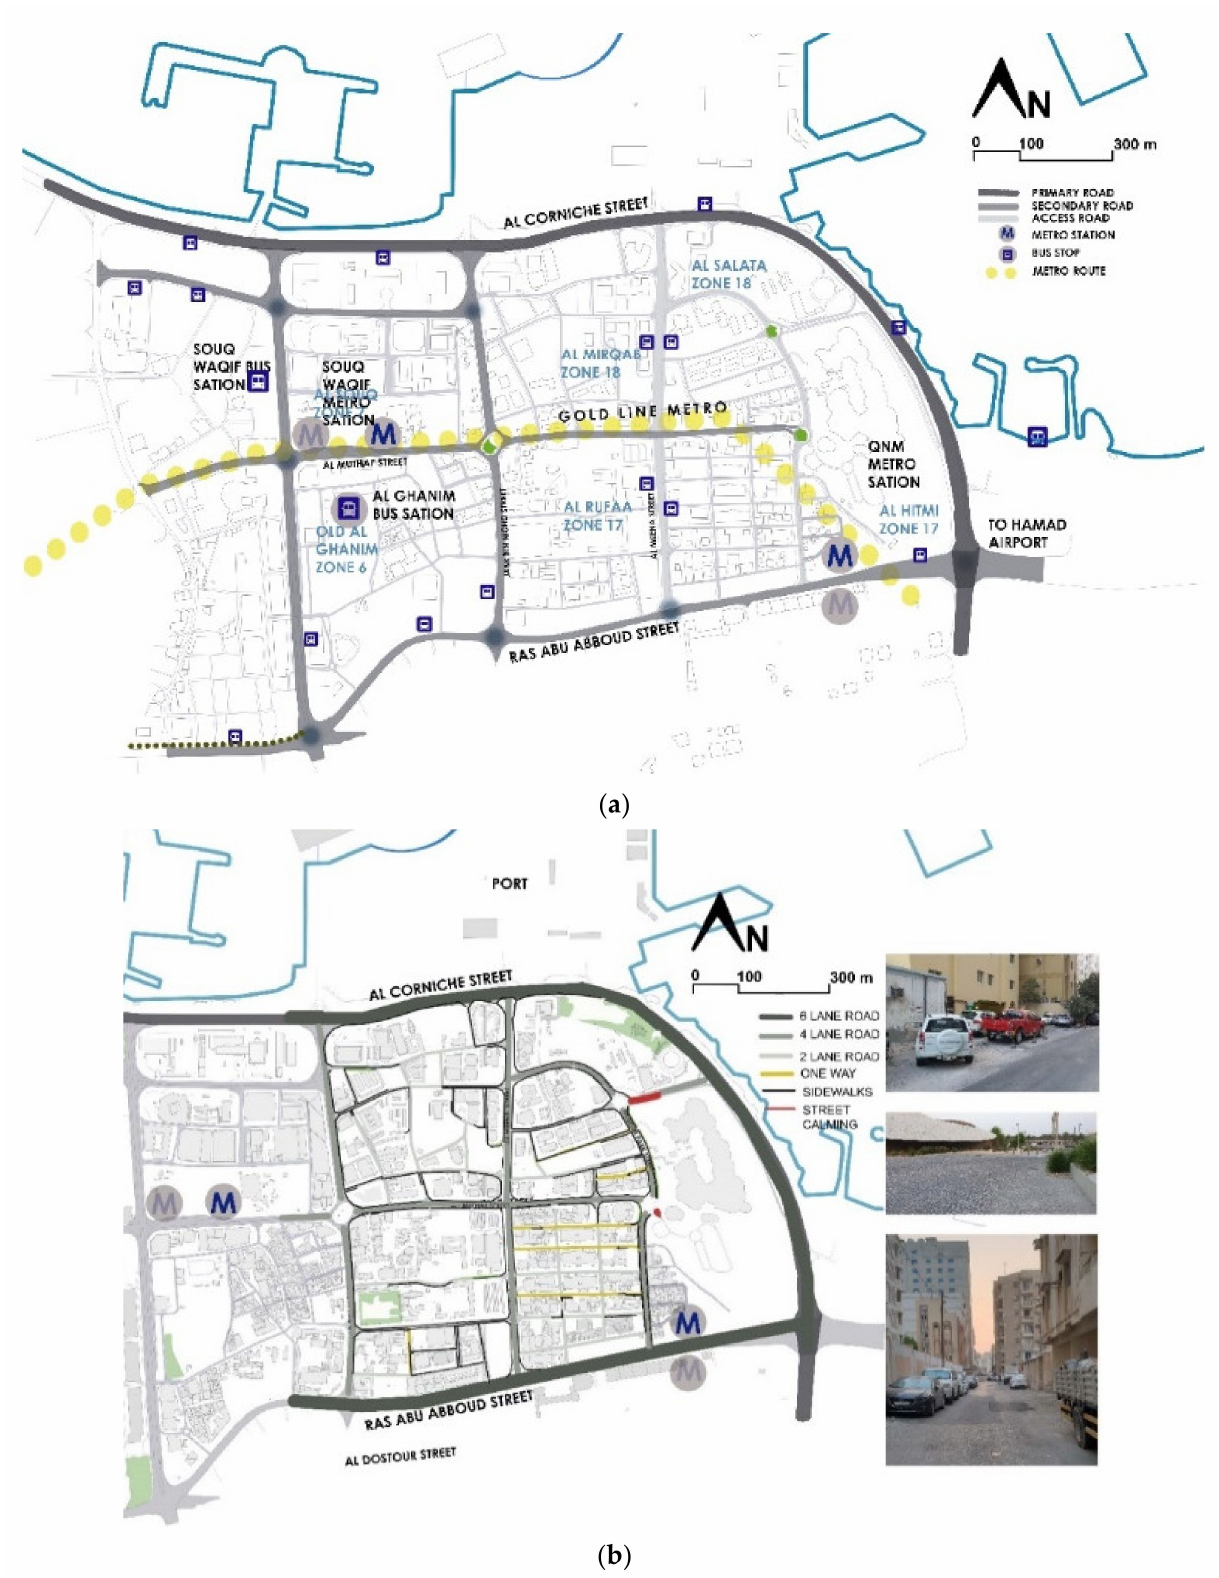
Figure 4. ( a ) Transportation network of the study area. ( b ) Street hierarchy of the study area. Private vehicles are heavily used along with occasional buses. In general, an overlap- ping usage of different transit systems is evidently absent since the multi-modal